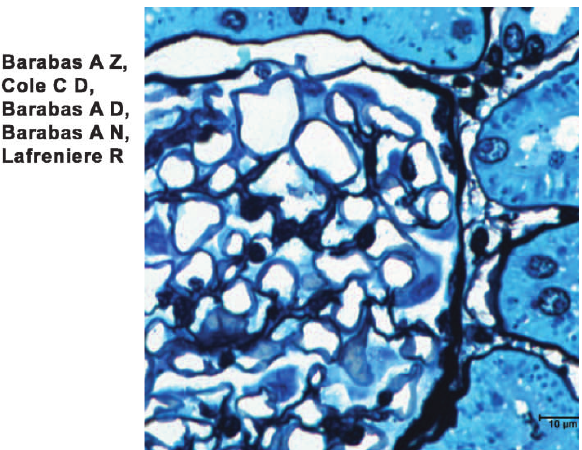
Figure 1. Evenly thin glomerular capillary loops show no morphological changes in the kidney sections of test and control group rats. PASM stained